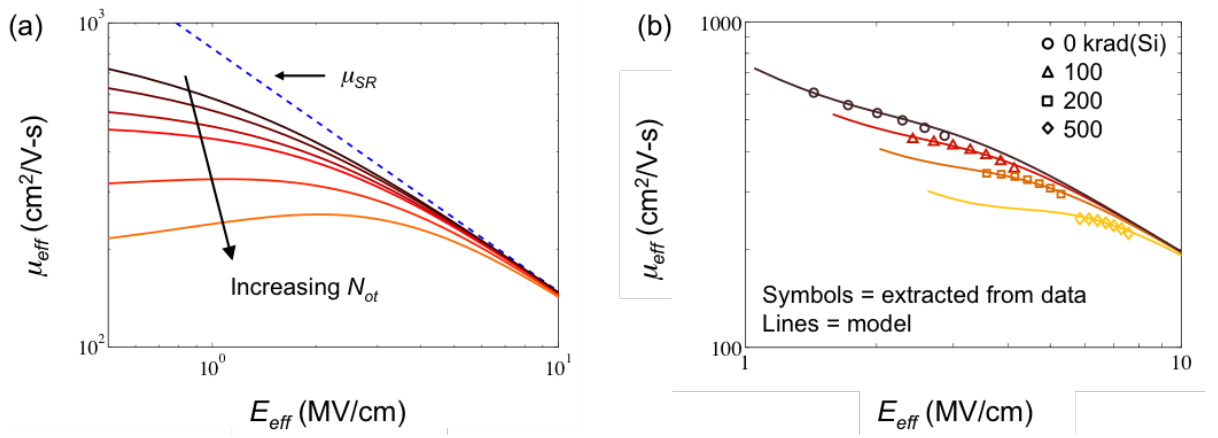
) using Equations 5–7 and eff ) for increasing values of N . The eff ot